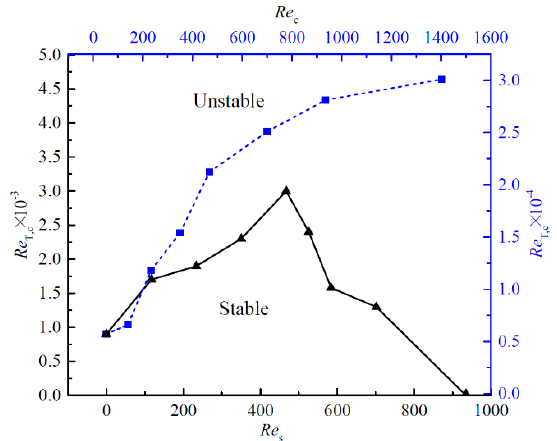
Figure 6. Critical conditions for the iso-rotation of crystal and crucible.